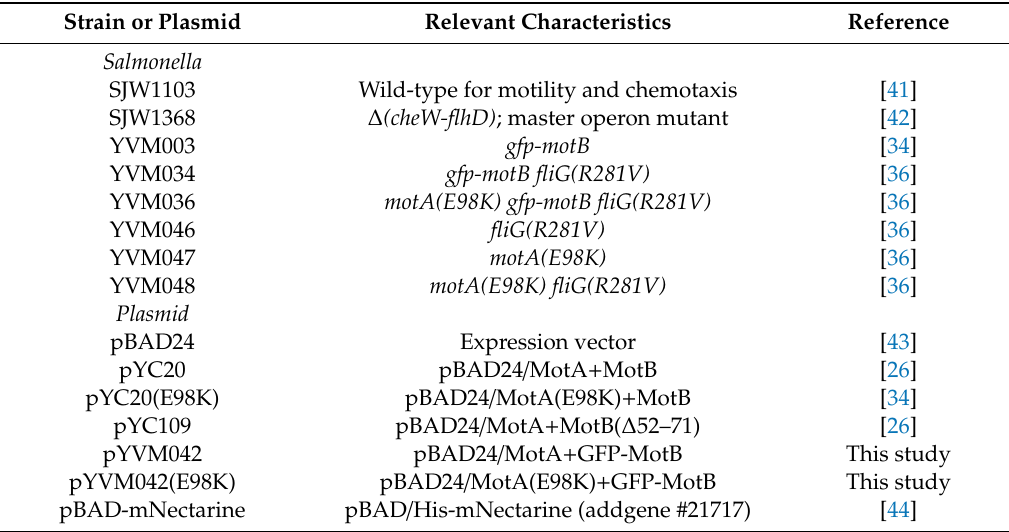
Table 1. Bacterial strains and